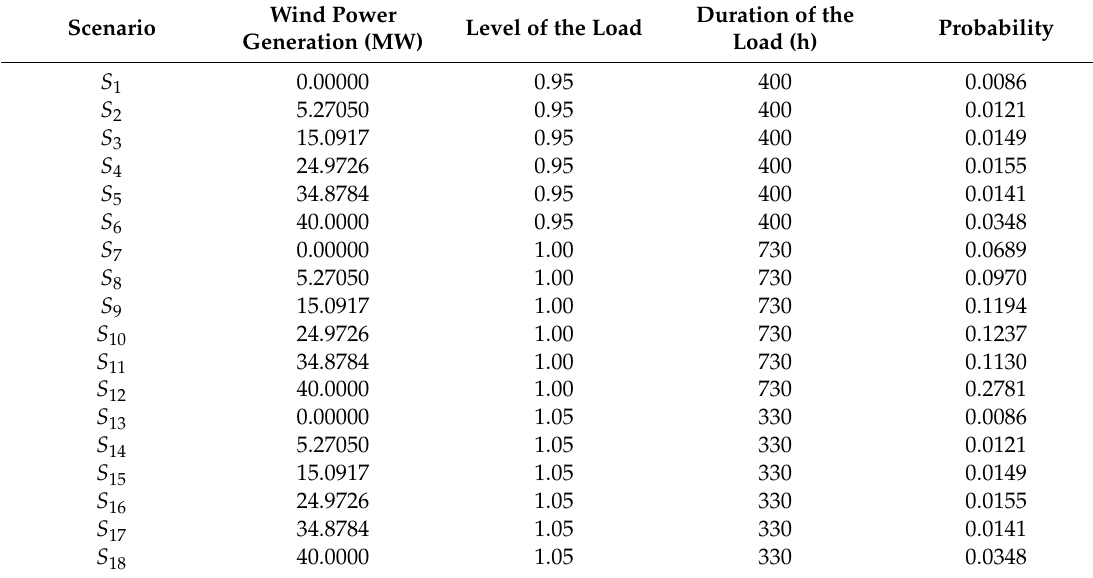
Table 15. Generated load-wind scenarios for probabilistic multi-objective RPP considering load demand and wind power generation